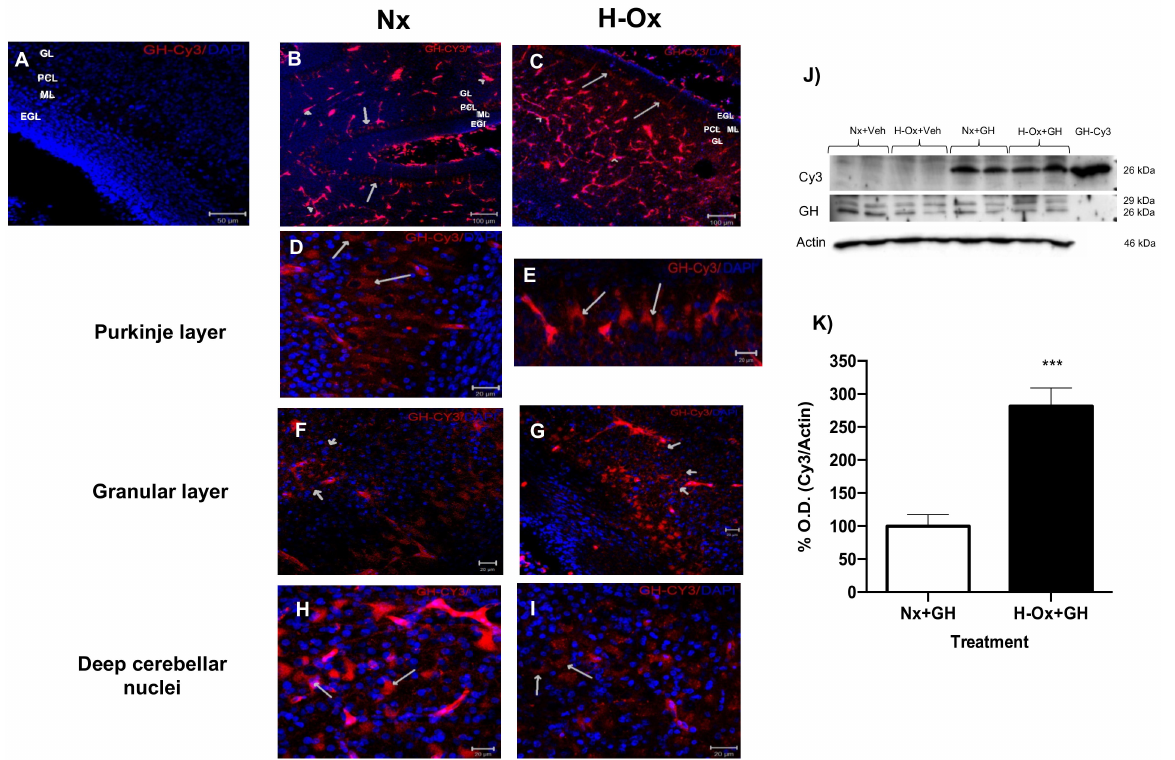
Figure 4. Distribution of Cy3-GH in cerebellar layers after 2 h of administration through the chorio- allantoic vein of chicken embryos. ( A ) Control animals that received only vehicle (saline solution); ( B , D , F , H ) animals injected with Cy3-GH but maintained under normoxia; and ( C , E , G , I )) animals exposed to hypoxia injected with Cy3-GH. Arrows indicate the presence of Cy3-GH in cerebellar cells in the following regions: ( D , E ) Purkinje layer, ( F , G ) granular layer, and ( H , I ) deep nuclei. The integrity of the Cy3-GH was validated by Western blot in cerebellar homogenates. The added fluorescent hormone (Cy3) had a similar molecular weight (26 kDa) as the GH-IR band under both normoxic and hypoxic conditions. As expected, no Cy3 band was observed in animals that received only vehicles. Nx+Veh (n = 3), H-Ox+Veh (n = 3), Nx+GH (n = 5), H-Ox+GH (n = 4). ( J , K ) Densitometric analysis of WB shows the relative proportion of Cy3-GH found in cerebellar extracts under normoxia (Nx) and hypoxia (H-Ox) conditions. Bars represent mean ± SEM. Asterisks (***) indicate significant differences p < 0.001, by Student’s t -test. Abbreviations: EGL: external granular layer, ML: molecular layer, PCL: Purkinje cell layer, GL: granular layer. Scale bar 20 µ m in ( D – I ); 50 µ m in ( A ), and 100 µ m in ( B , C